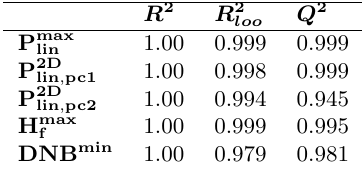
Table B.2. Kriging models validation for BE coupling.